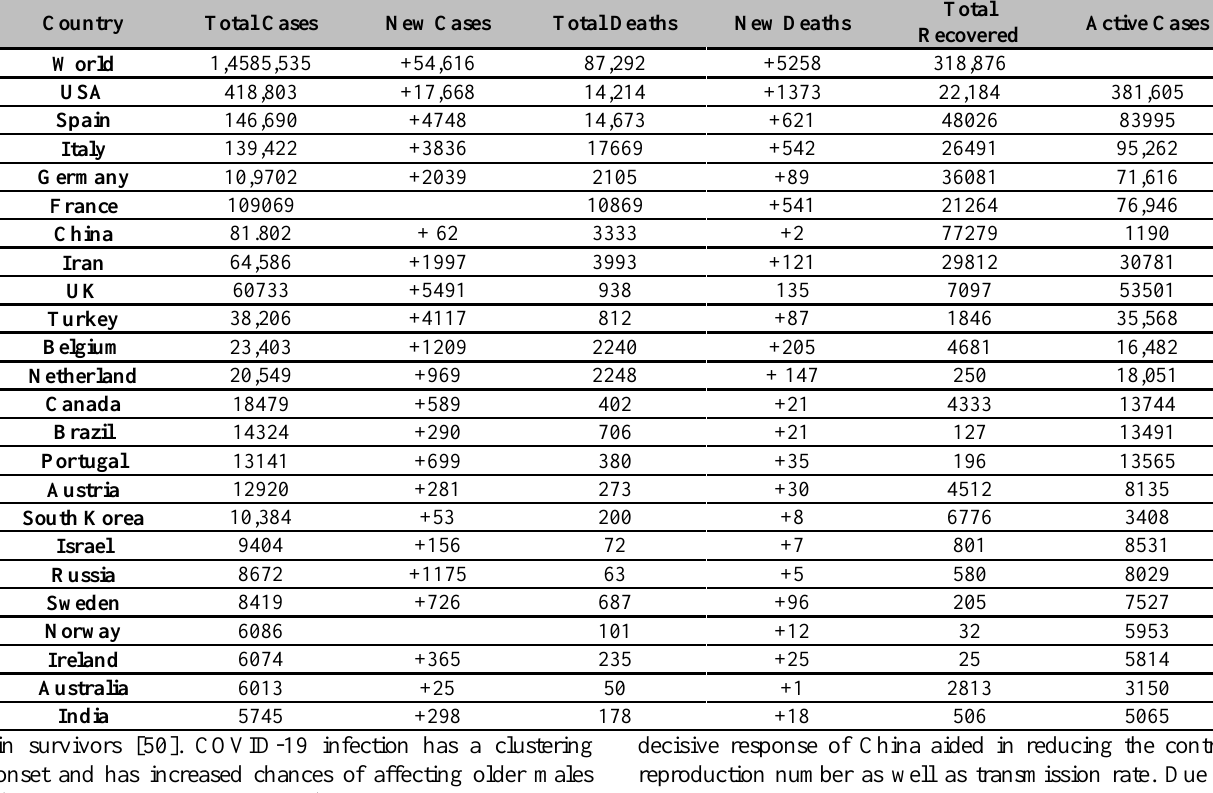
Table 1. Worldwide epidemiology of COVID-19 (data updated until 8 th of April, 2020